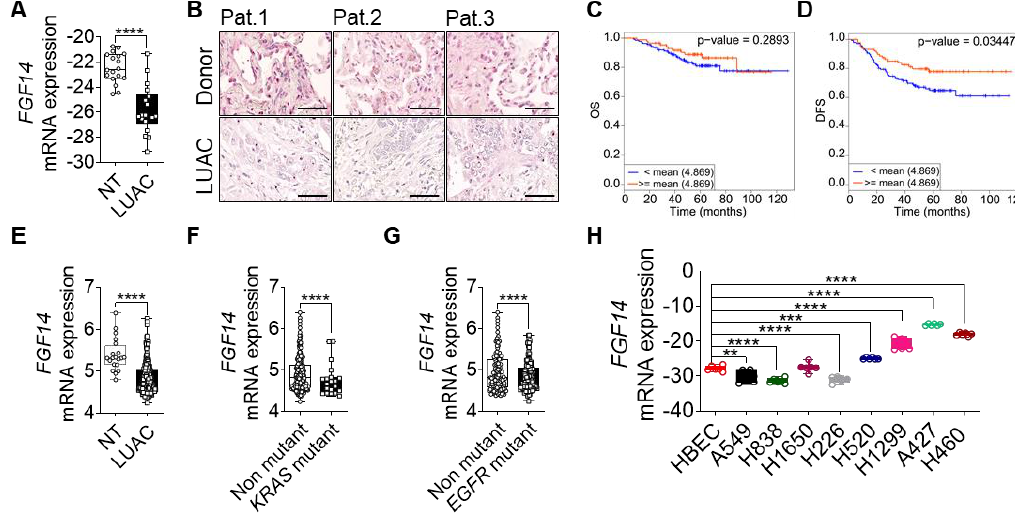
Figure 1. Clinical outcome associated with FGF14 expression in lung adenocarcinoma (LUAC). ( A ) mRNA expression analysis of FGF14 in LUAC patients samples ( n = 18) compared to non-tumor tissue (NT). ( B ) Immunohistochemical staining of FGF14 in LUAC and healthy donor tissue samples ( n = 3). Scale bar 50 µ m. Kaplan–Meier estimate of ( C ) overall survival (OS) and ( D ) disease free survival (DFS) among Okayama patients dataset with LUAC that was classified according to the levels of FGF14 mRNA as either high (above the mean value of FGF14 mRNA levels; red) and low (below the mean value of FGF14 mRNA levels; blue). ( E ) mRNA expression level of FGF14 in LUAC samples from the same study compared with non-tumor tissue. ( F ) Analysis of FGF14 expression in KRAS mutant vs KRAS non-mutant patients samples and ( G ) EGFR mutant vs EGFR non-mutant samples. ( H ) mRNA expression of FGF14 in di ff erent lung cancer cell lines e.g., LUAC (A549, H1299, H838, and H1650), LUSC (H226. and H520), lung carcinoma (A427) and large cell lung cancer (H460) compared with primary human bronchial epithelial cells (HBEC). Data obtained from CANCERTOOL ( C – G ). Data shown as mean +/ - standard error of the mean using Student’s t -test. P -values ≤ 0.05 were considered statistically significant for all analyses. ** p ≤ 0.01, *** p ≤ 0.001 and **** p ≤ 0.0001.